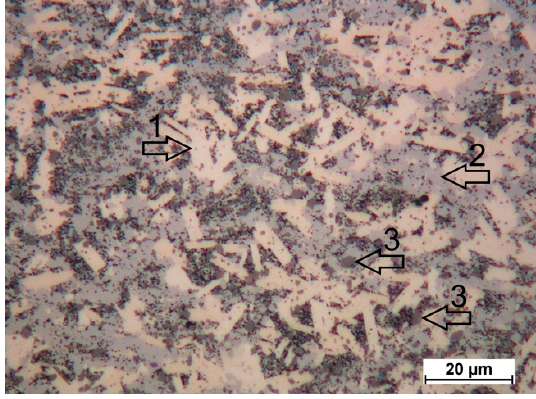
Figure 7. LM micrograph of composite SPSed at 1350 °C.